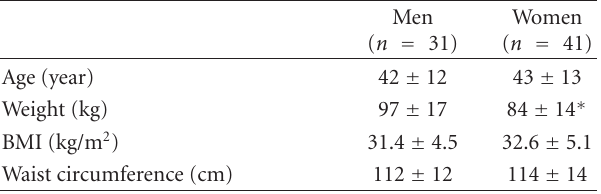
Table 1: Descriptive characteristics of First Nations adults from two northwestern communities of Ontario, Canada.